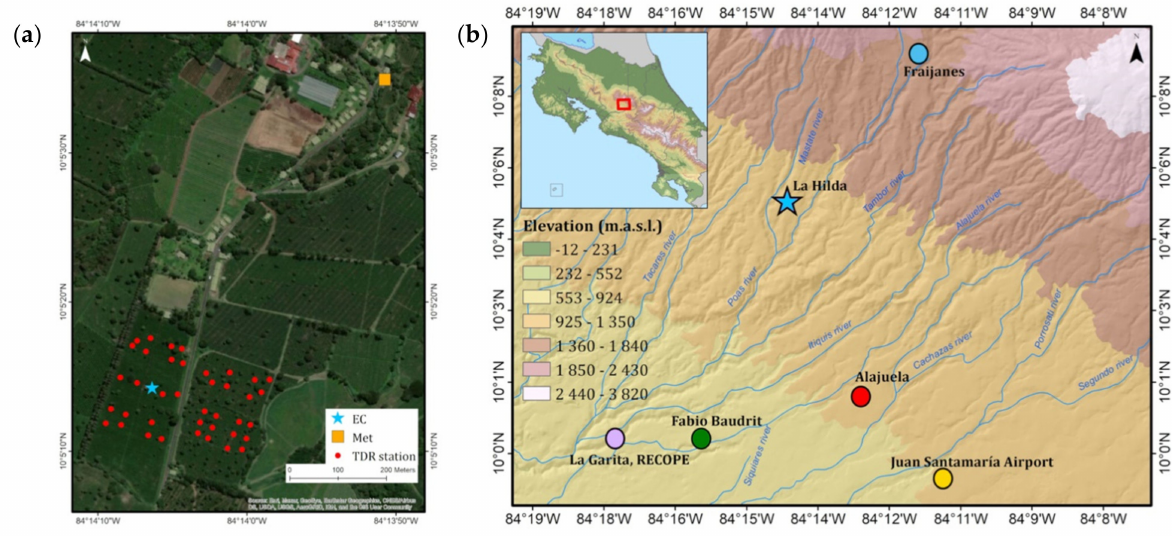
Figure 2. Geographic location of the study site, Finca La Hilda San Pedro de Po á s, Alajuela, Costa Rica. ( a ) Map with the distribution of the instrumentation (fluxes tower, sky blue star; meteorological station, orange square) and in situ measurement sites (soil respiration and moisture in red circles); ( b ) locations of the long-term weather stations used for the climate analysis based on the 1999–2019 period; the experiment site is marked with a star symbol that refers to the site marked by the same symbol in ( a ). The orography in the area is such that relatively short distances (~10 km) have enough slope to cause relevant temperature differences between the